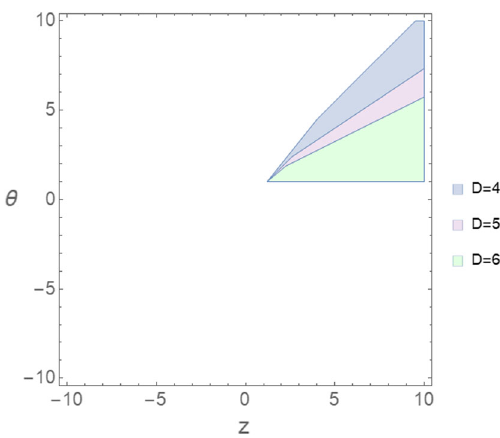
Fig. 4 The colored regions depicts the sectors of the parameter space where the NEC are satisfied. This includes its solid curved boundaries. We show three cases: D = 4 (blue), D = 5 (light purple), D = 5 (light green), where the allowed region of the lower dimensions includes that of the higher dimensions. While the area reduces with a greater D , there isalwaysaregionofvalidity.Other ( z ,θ) combinationsinsidetheblank area will lead to violation of the energy conditions